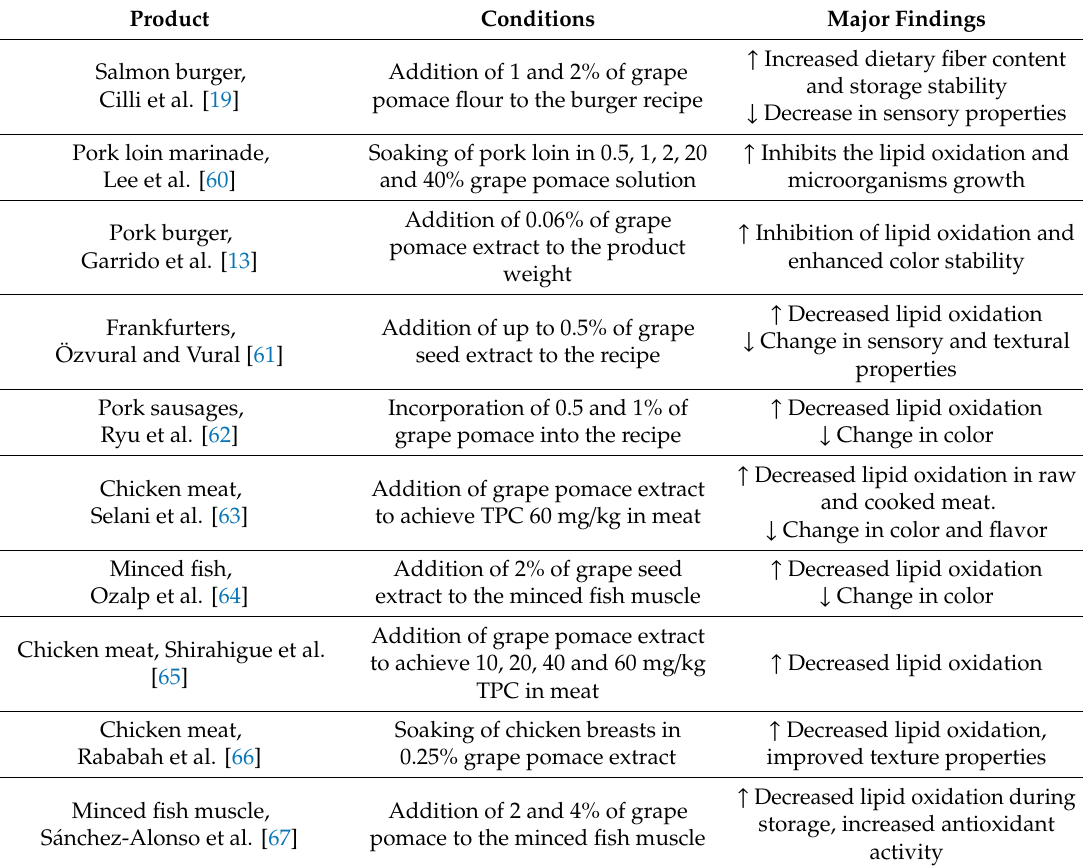
Table 3. E ff ect of addition of grape pomace to the meat and fish